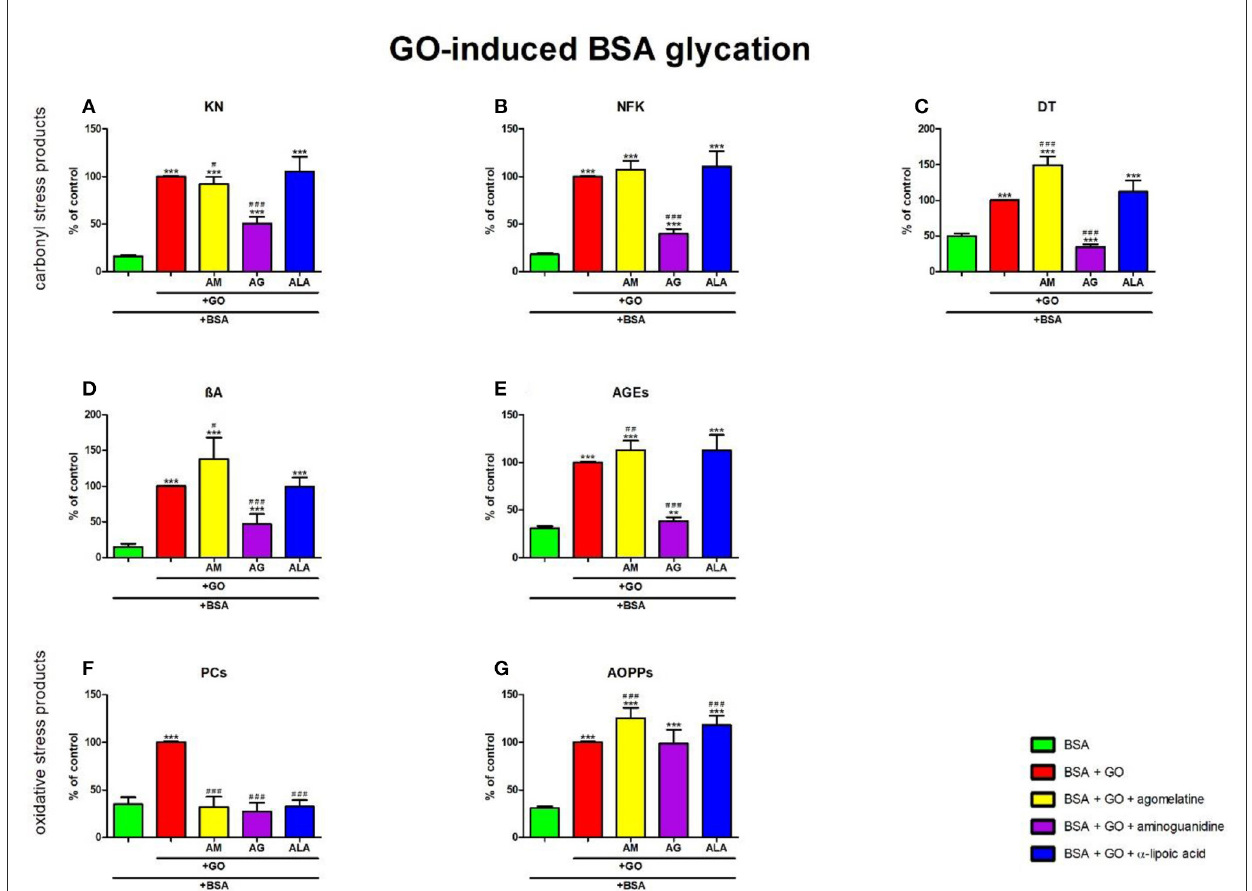
FIGURE8 Effects of agomelatine addition to glyoxal (GO)-glycated bovine serum albumin (BSA) on carbonyl stress products (A–E) and oxidative stress products (F, G) . AG, aminoguanidine; AGEs, advanced glycation end products; ALA, α -lipoic acid; AM, agomelatine; AOPPs, advanced oxidation protein products; β A, β -amyloid; BSA, bovine serum albumin; DT, dityrosine; GO, glyoxal; KN, kynurenine; NFK, N-formylkynurenine; PCs, protein carbonyls. ** p < 0.01 vs. negative control (BSA); *** p < 0.001 vs. negative control (BSA); # p < 0.05 vs. positive control (BSA + GO); ## p < 0.01 vs. positive control (BSA + GO); ### p < 0.001 vs. positive control (BSA +